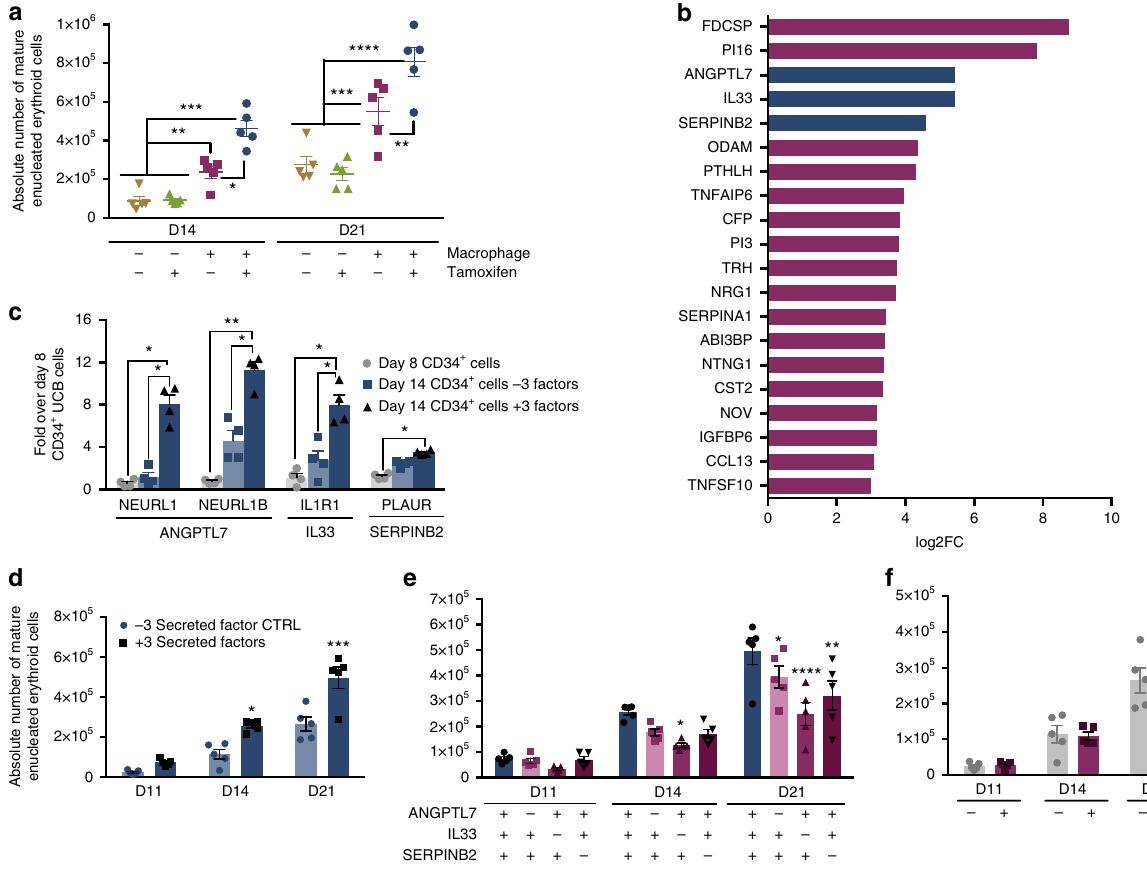
Fig. 4 Paracrine mechanism involved in erythroid maturation. a Quanti fi cation and statistical analysis of the absolute number of fully mature enucleated erythroid cells in replicate experiments where cells were differentiated alone or in the presence of iKLF1.2-DMs ( − / + tamoxifen) where cell contact was inhibited using a trans-well ( n = 5 biologically independent samples; two-way ANOVA with Tukey ’ s post-test). b Validated top-20 most differentially expressed genes encoding secreted factors that were upregulated by KLF1 in iKLF1.2-DMs categorized by descending log2 fold change in expression ( p